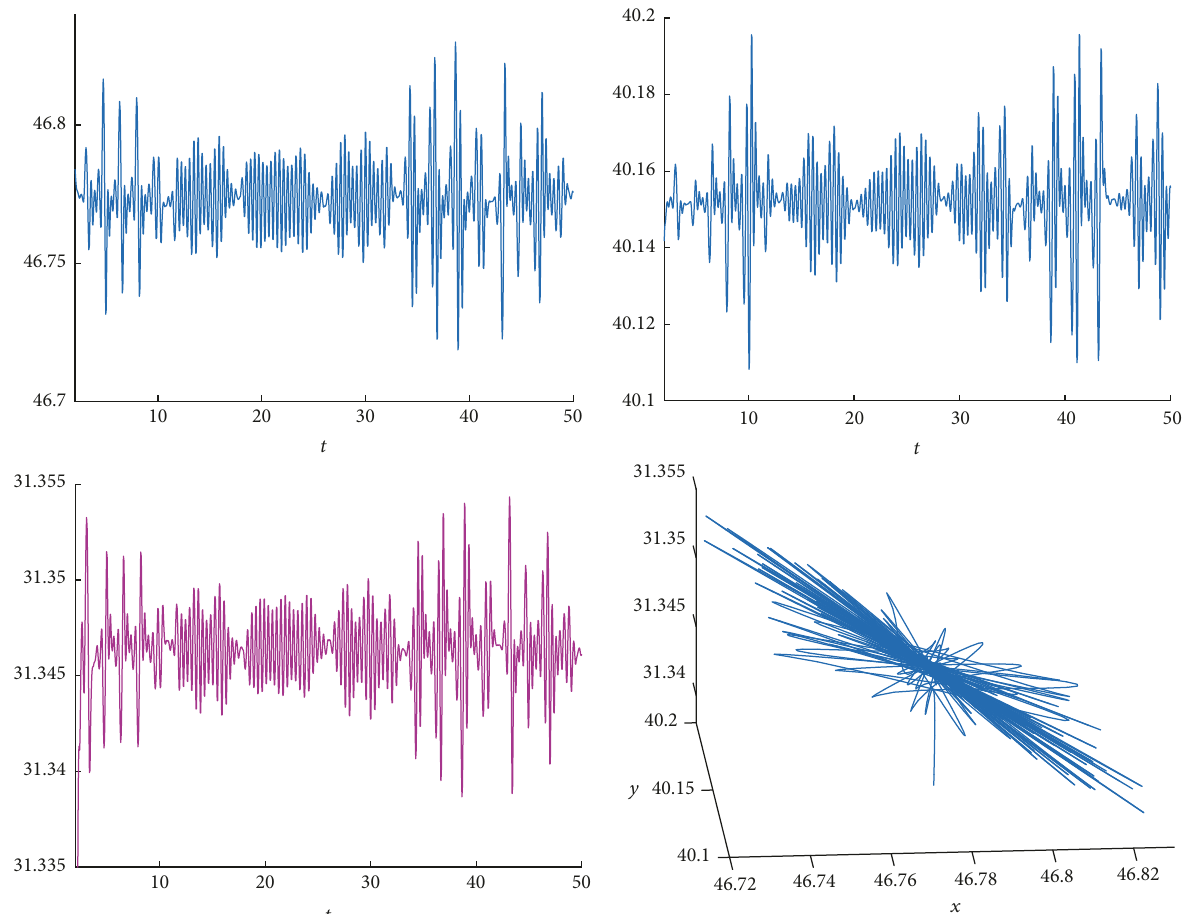
Figure 1: Dynamical behaviors and phase space trajectories of the three fish populations.